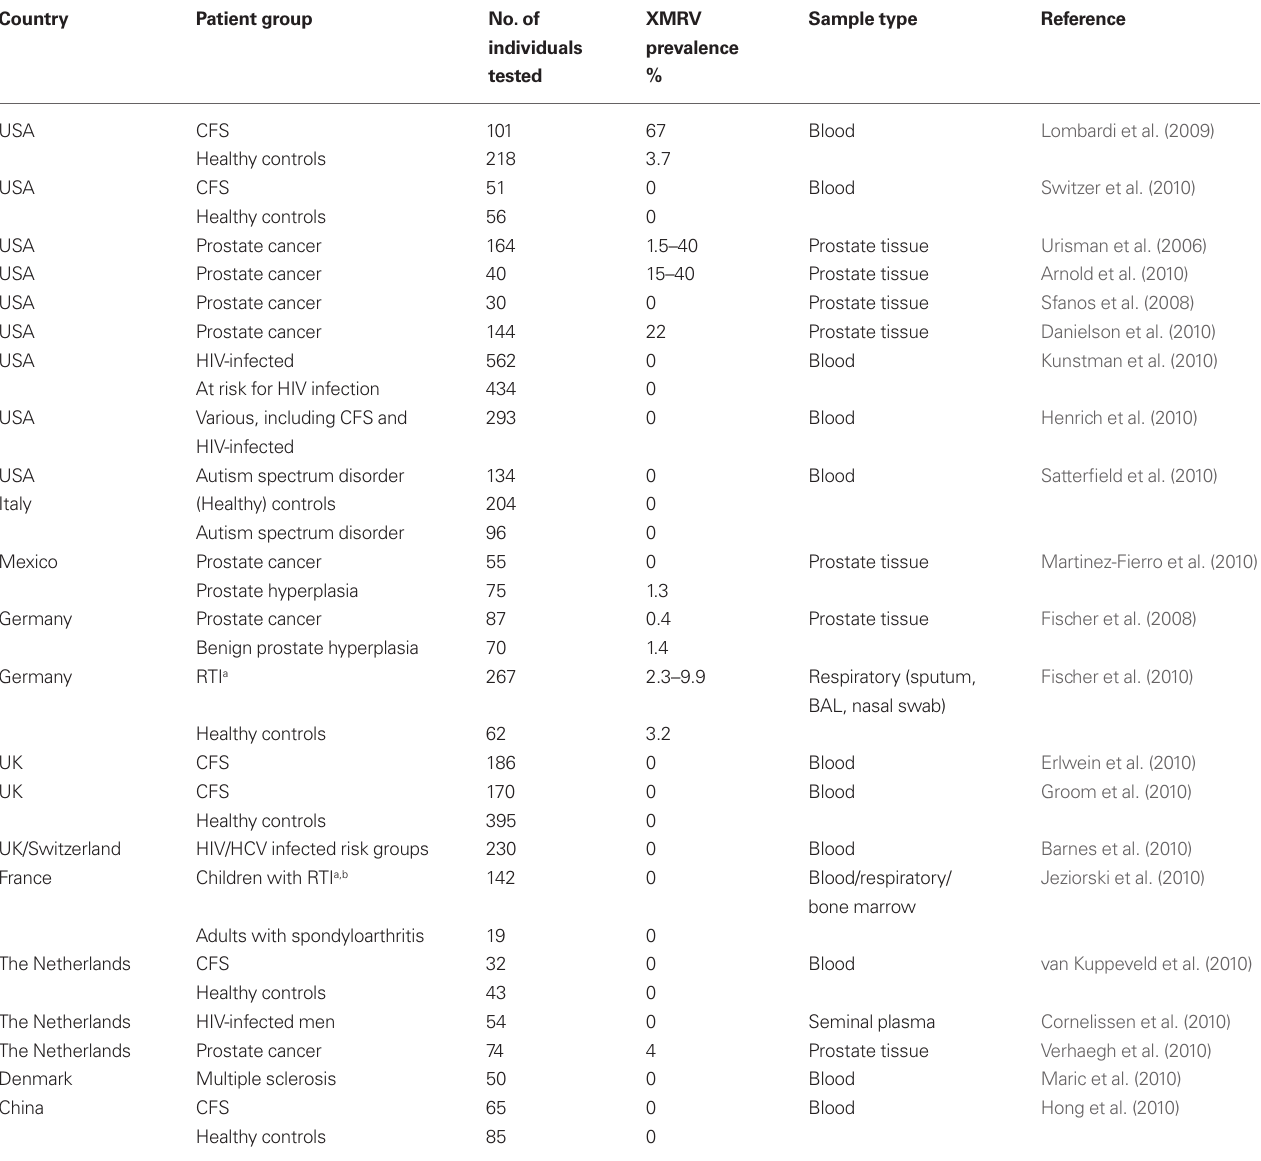
Table 1 | XMRV prevalence and geography.